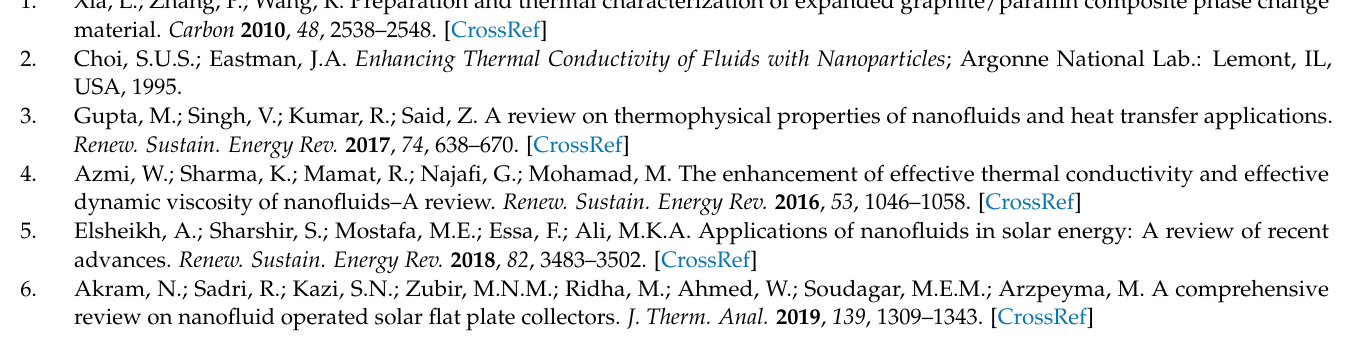
Figure 6. Specific heat capacitance as a function of mass fraction of ( a ) liquid at 70 °C and ( b ) solid at 20 °C. Squares: M15; rhombuses: Μ 5; triangles: C750.